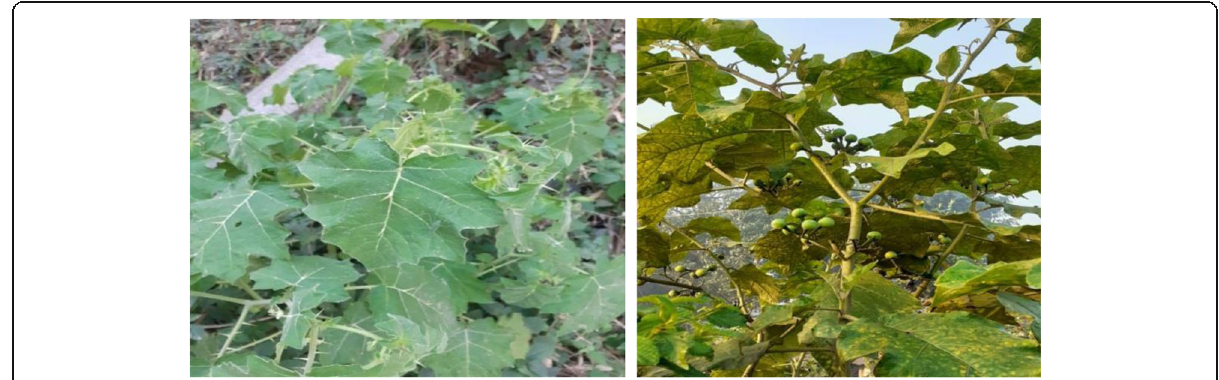
Fig. 1 Solanum virginianum plant displaying Leaves and